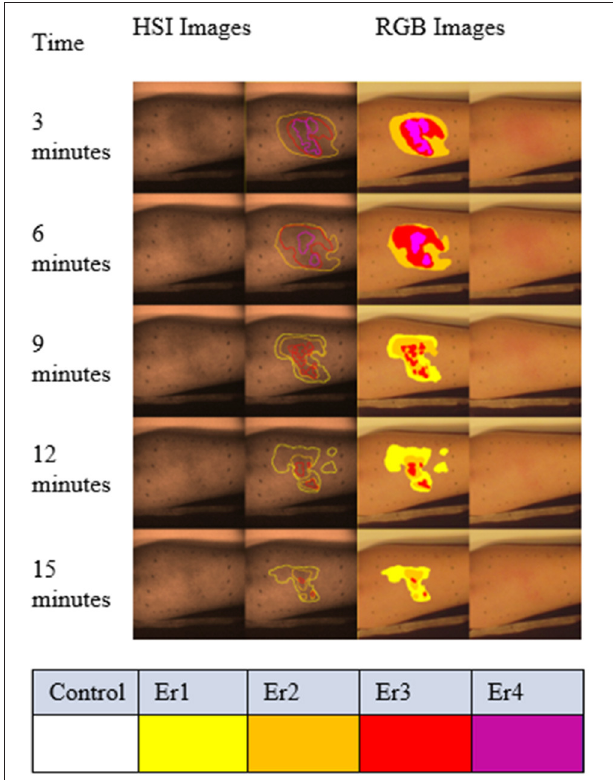
FIGURE 7 | Graded regions of different erythema levels overlaid with color (right two columns) and spectral images (gray scale images in the left two columns) from one volunteer. The sequence from top to bottom is based on the time scale of imaging. The spectral images in this figure were captured at 540nm, which is one of the absorption peaks for oxyhemoglobin. The spectral images in the right column are overlaid with the radiotherapists’ grading results. Similarly, the graded results are shown for the color images. The different levels of erythema are color-coded: very faint erythema (Er1) in yellow, faint erythema (Er2) in orange, bright erythema (Er3) in red and very bright erythema (Er4) in magenta.